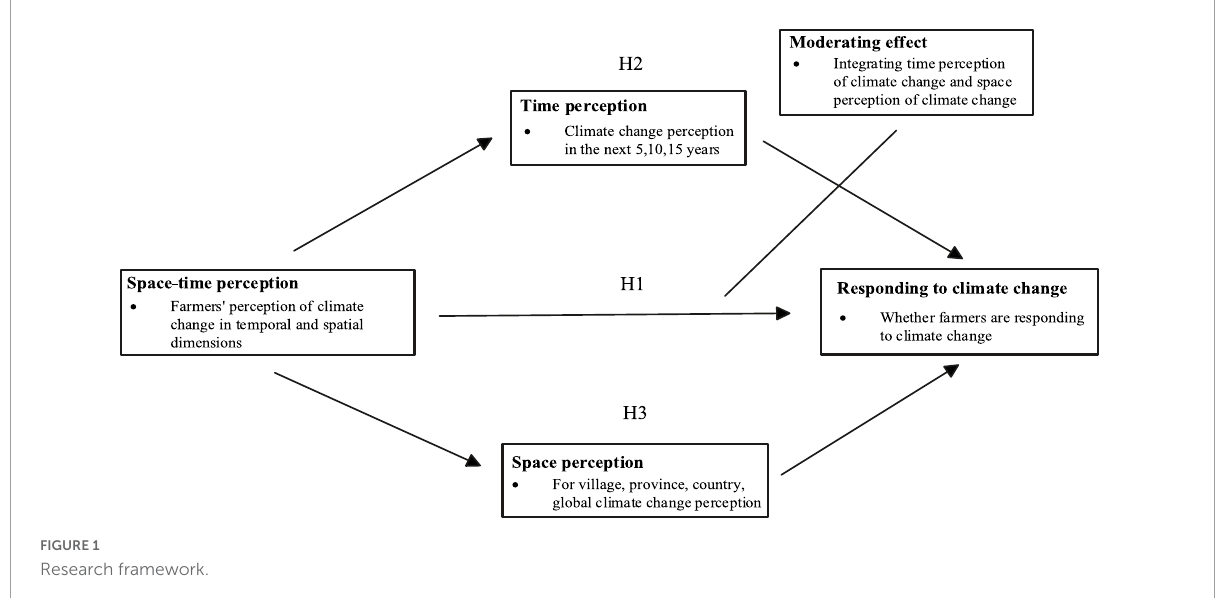
FIGURE1 Research